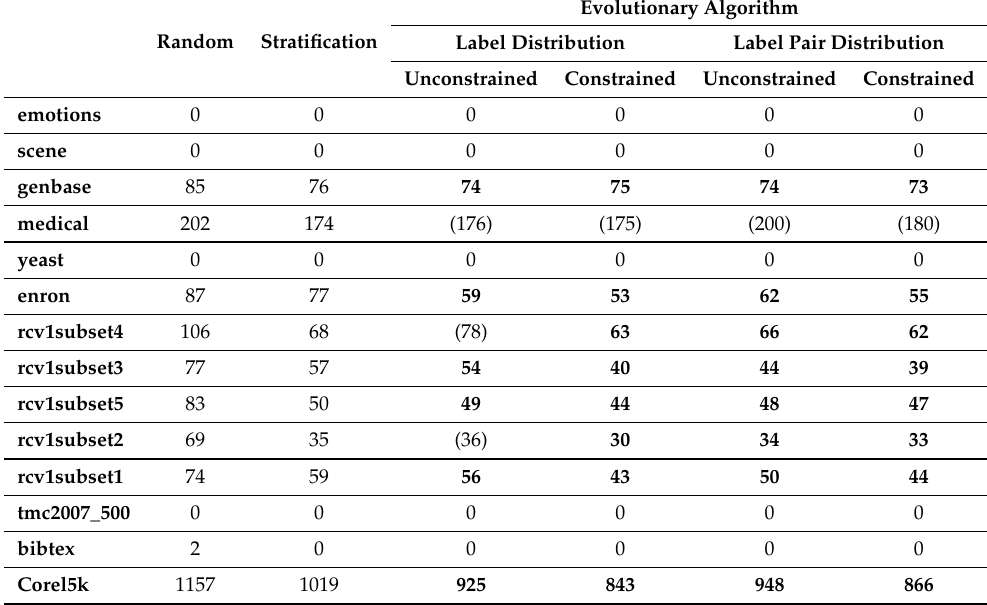
Table 7. Number of fold-label pairs with zero positive examples ( FLZ ) of different splitting algo- rithms. In bold the results that are better than the stratification method. Between brackets those results that are